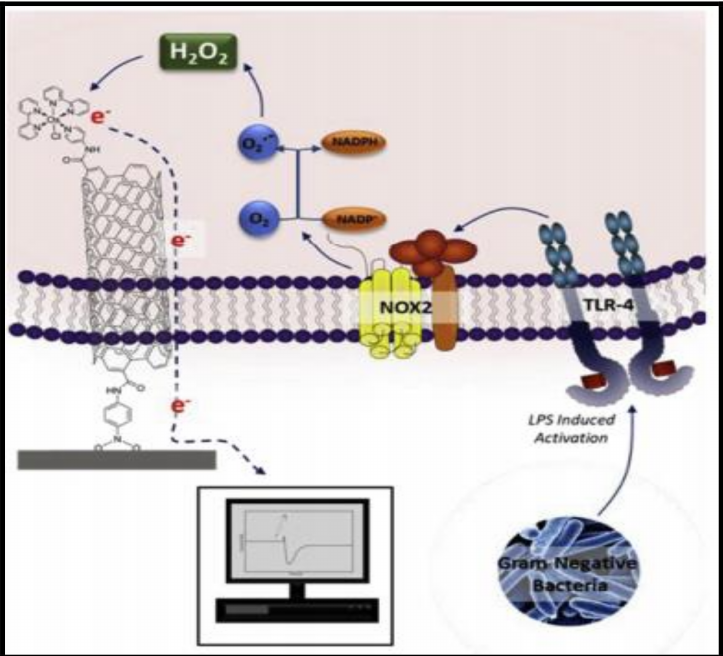
Figure 3. Schematic representation of pathway of detecting pathogenic bacteria through intracellular reactive oxygen species, reproduced with permission from [34] (J.M. Hicks et al., 2019).